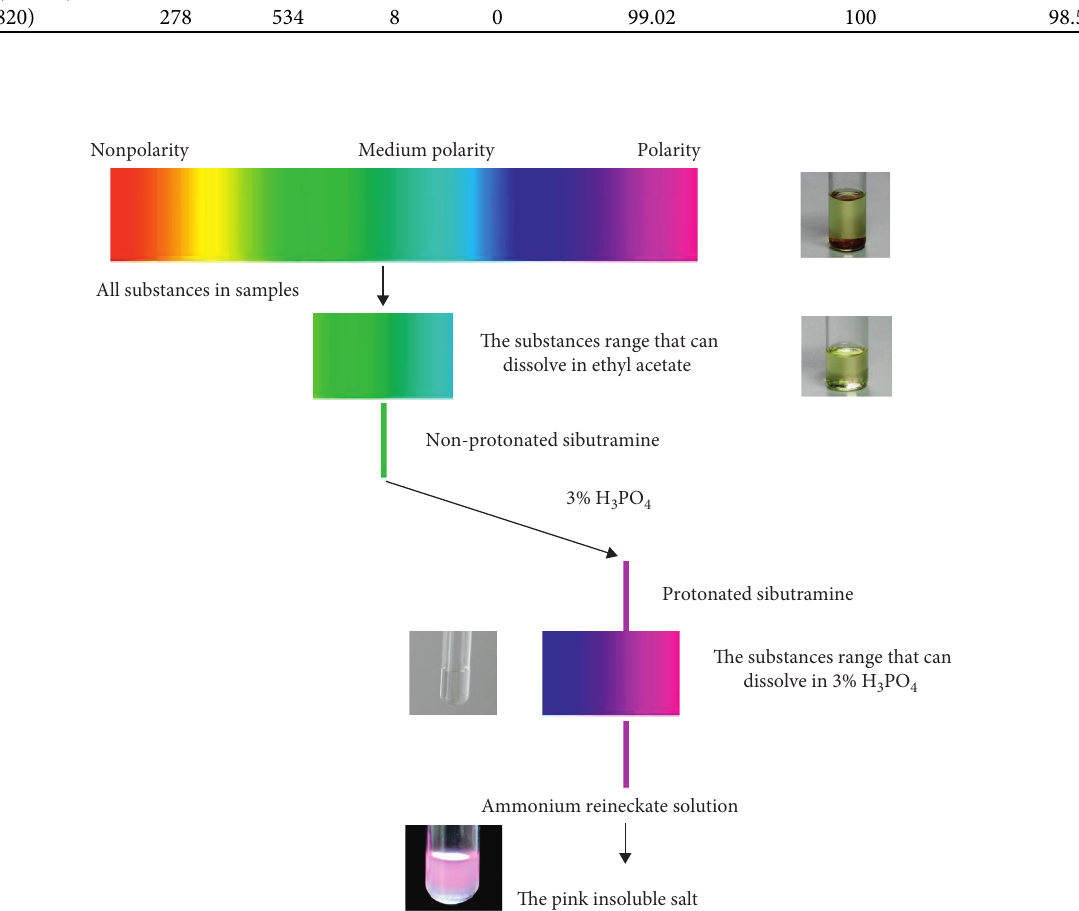
Figure 2: General schematic of the rapid screening